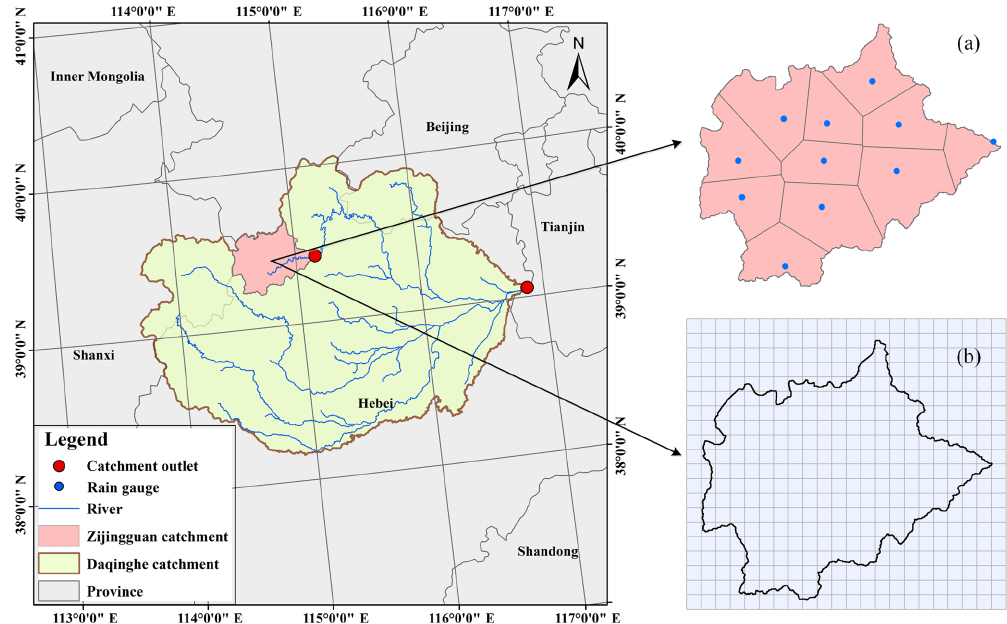
Figure 1. The location of the Zijingguan catchment with (a) the 11 rain gauges and (b) the 3km × 3km grid